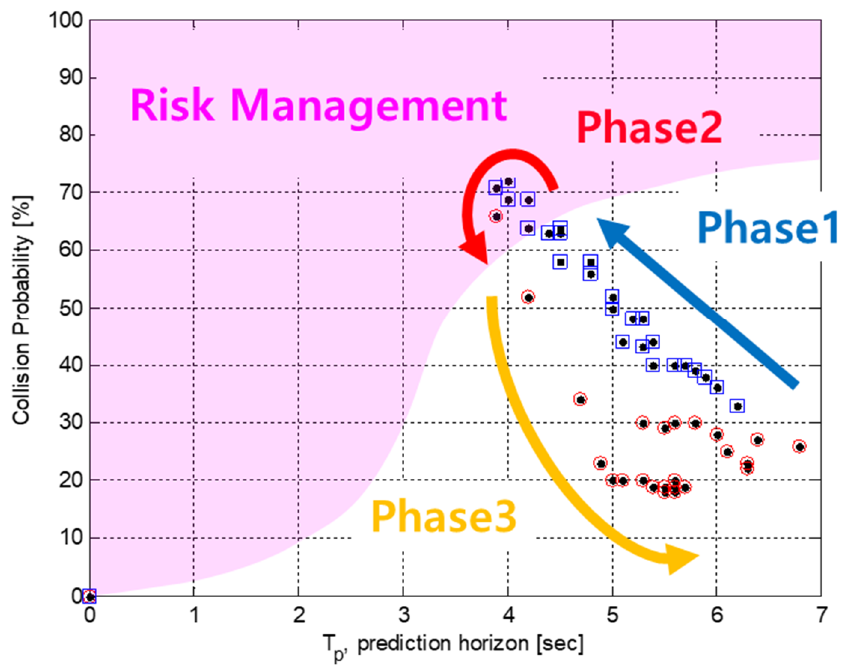
Figure 5. Risk management strategies.